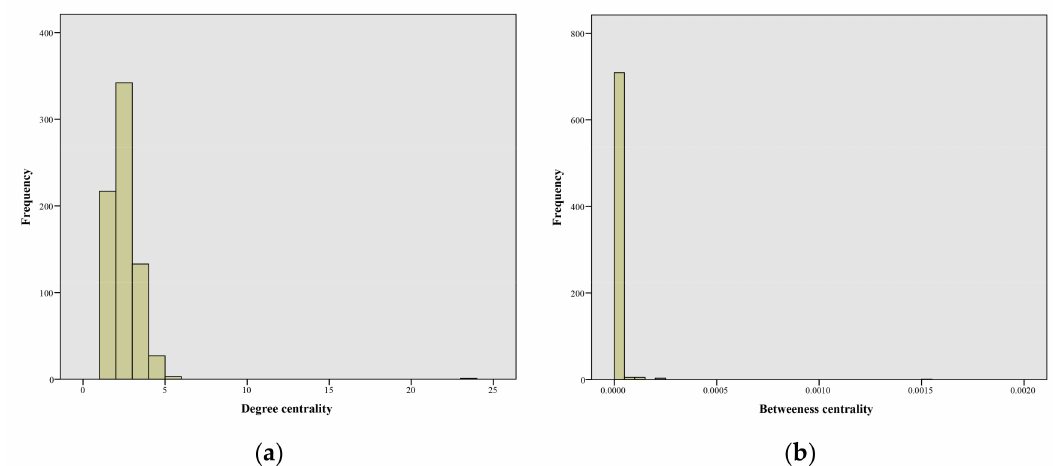
Figure 11. Frequency distribution of centrality of settlements based on the strongest gravitational connection method: ( a ) Degree centrality; ( b ) Betweenness